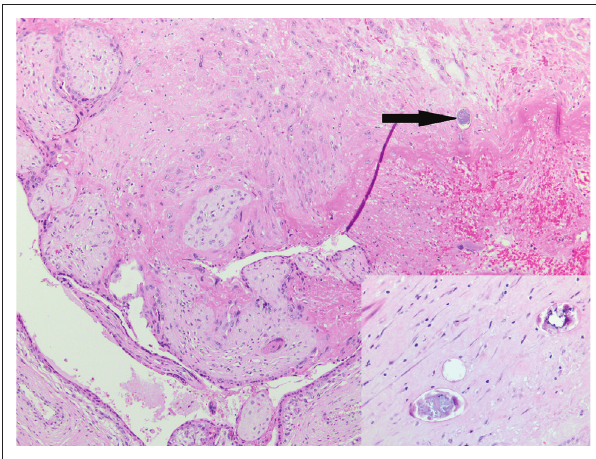
FIGURE 7: Bone marrow trephine biopsy with numerous parvovirus inclusions (arrows) (original magnification × 400).